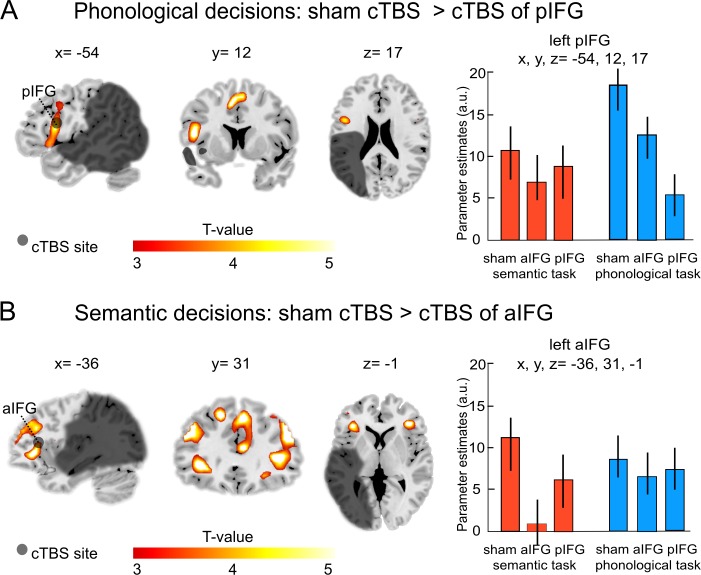
Task-specific continuous theta burst stimulation (cTBS) effects on word decisions.(A) Phonological decisions. Relative to sham cTBS, cTBS of pIFG significantly decreased neural activity at the stimulated area. (B) Semantic decisions. Relative to sham cTBS, cTBS of aIFG significantly decreased neural activity in a larger network, including the bilateral anterior insula and adjacent aIFG. Right panels display the respective parameter estimates (arbitrary units) for the different cTBS conditions that were extracted at the respective mean group peak coordinates from the effect of interest for each task condition against rest. p<0.001 uncorrected for display reasons. a/pIFG = anterior/posterior inferior frontal gyrus. Coordinates are given in MNI space.